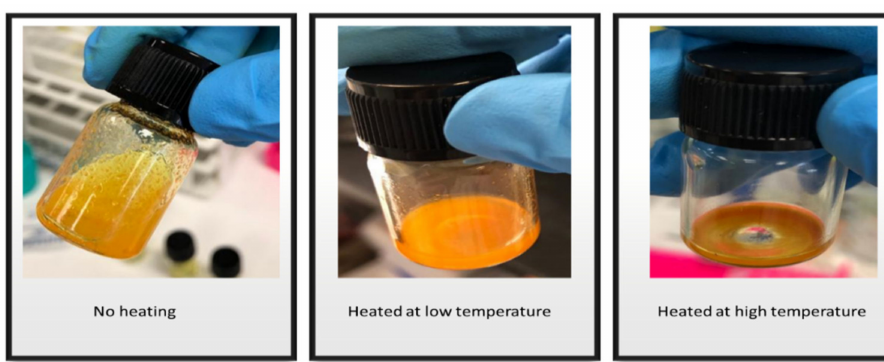
Figure A3. Effect of heat on the solubility of CUR in MCT. The CUR solubility escalates gradually with increasing